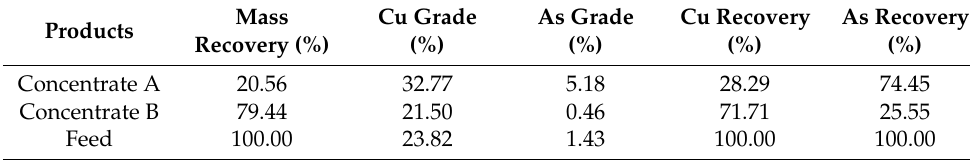
Table 2. Results of open-circuit flotation separation of the bulk copper